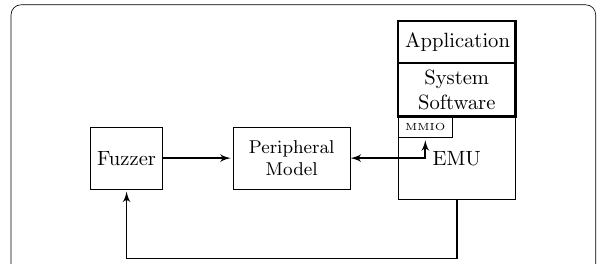
Fig. 6 Scheme of embedded fuzzing with peripheral